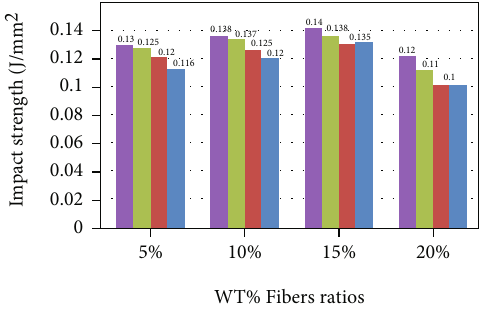
Figure 6: Impact strength for di ff erent lengths (2.5, 5, 7.5, and 10mm) and di ff erent weight ratios (5 wt%, 10 wt%, 15wt%, and 20wt%) of DPF in the tested RP-DPF